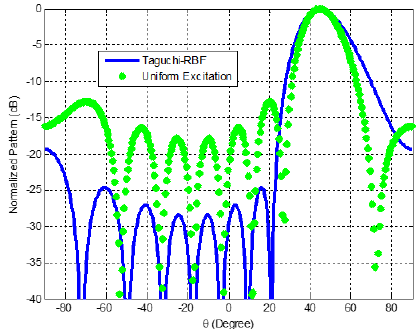
FIGURE 21. Radiation patterns of 8 Antipodal Vivaldi antenna@45° and frequency 5.8 GHz.